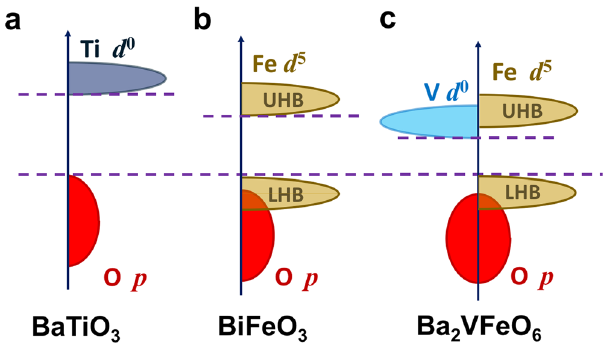
Figure 3. Comparison of gaps for different perovskite oxides. ( a ) BaTiO 3 ; ( b ) BiFeO 3 ; ( c ) Ba 2 VFeO 6 . ‘LHB’ (‘UHB’) means lower Hubbard bands (upper Hubbard bands). The valence band edges are aligned for